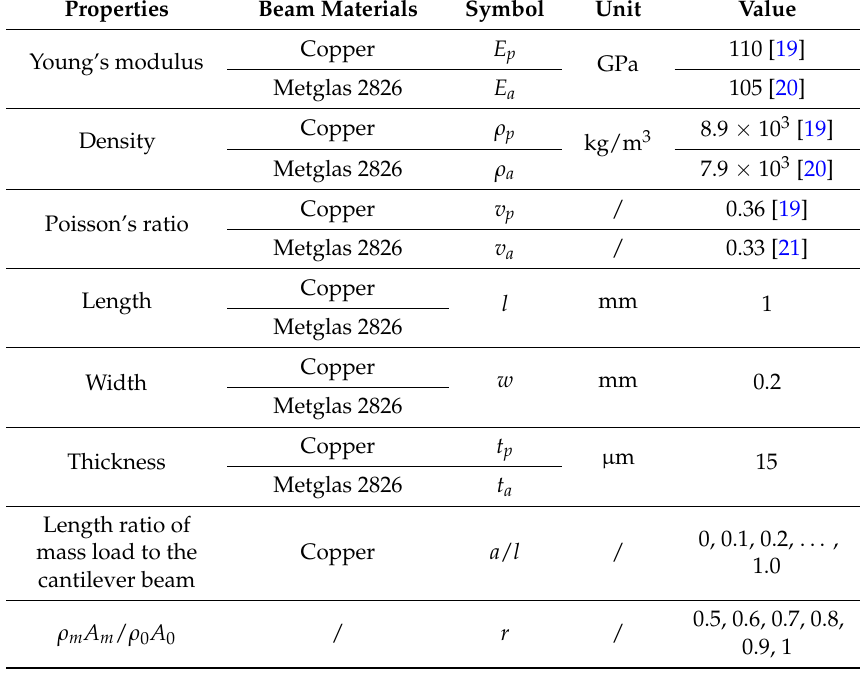
Table 1. The cantilever beam material properties and mass load conditions in this study.